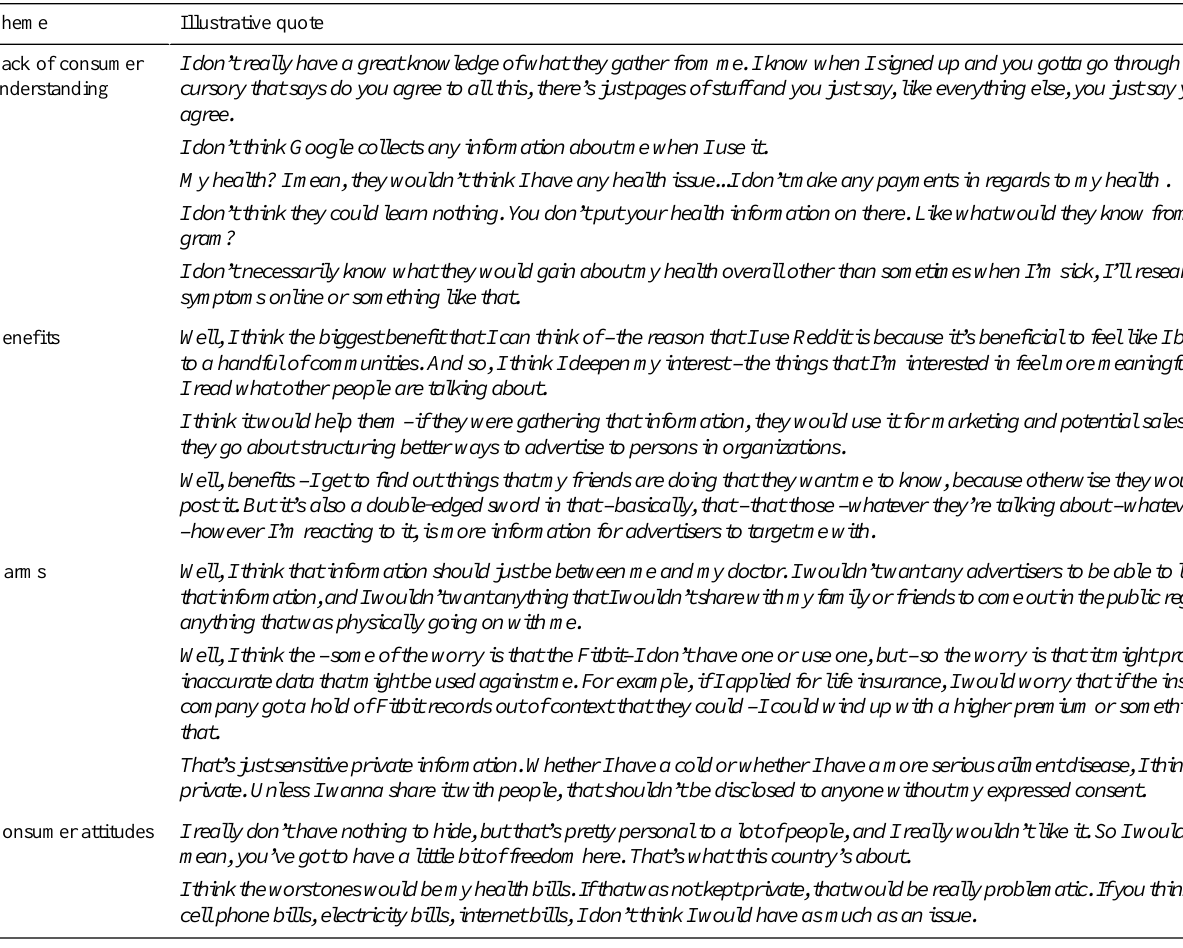
Table 3. Key themes from consumer interviews. Illustrative